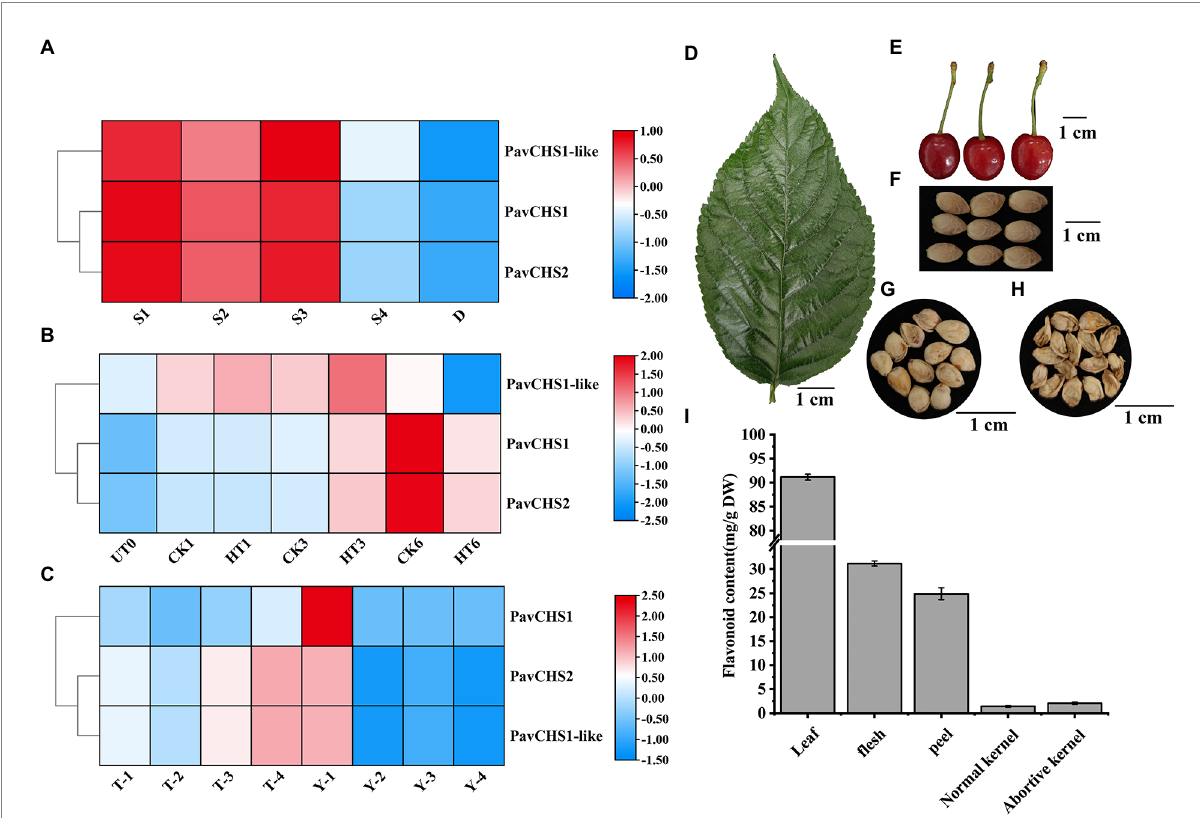
FIGURE 2 RNA-seq based expression patterns of PavCHS and flavonoid content in different tissues of Chinese cherries. (A–C) Expression patterns of PavCHS genes in RNA-seq of public databases; where (A–C) are flower bud differentiation, flower bud processing and fruit development, respectively. (D–H) Leaf and fruit tissues of Chinese cherries at maturity, scale bar is 1 cm. (I) Determination of flavonoid content in Chinese